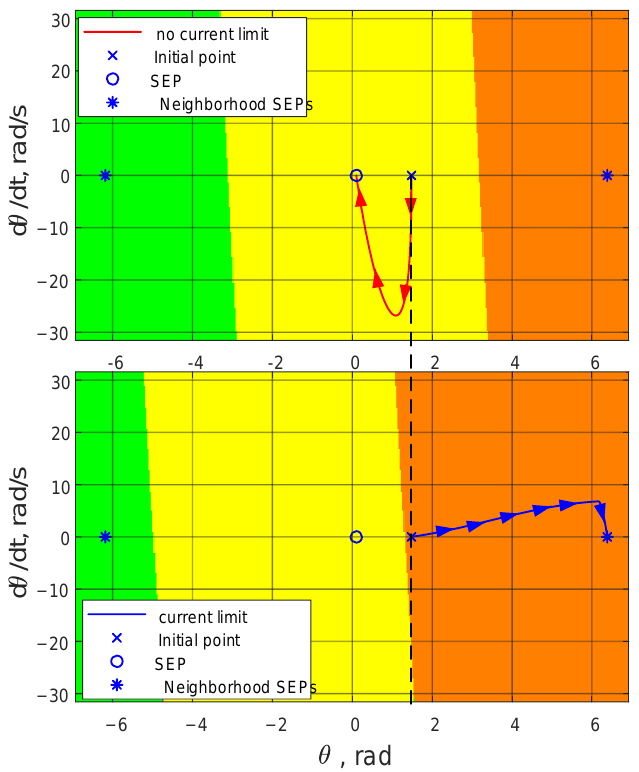
Figure 6. DOA for different systems and the trajectory of the operation points with the same arbitrary initial operation point ( SEP + 0.44 π , 0 ) . Top diagram: DOA for a current-unsaturated system; bottom diagram: DOA for a current-saturated system.